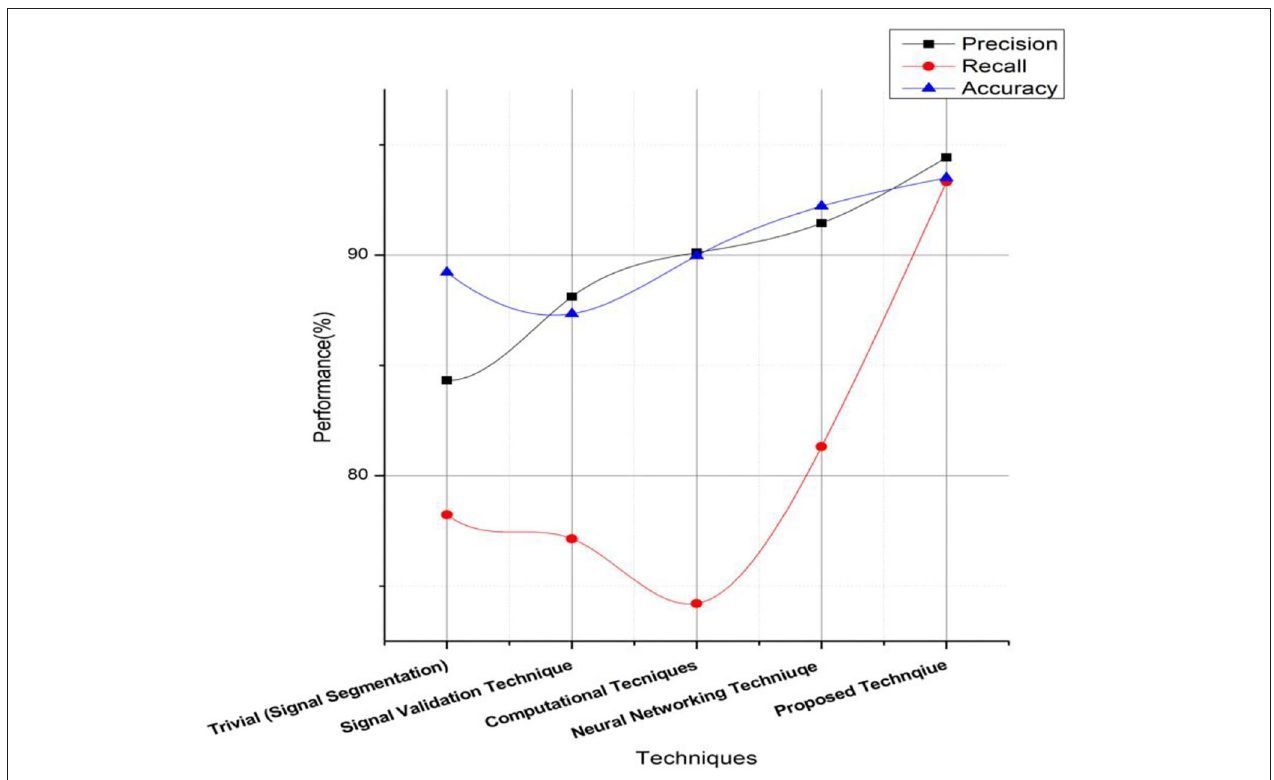
FIGURE 6 | Outcome evaluation of proposed technique.